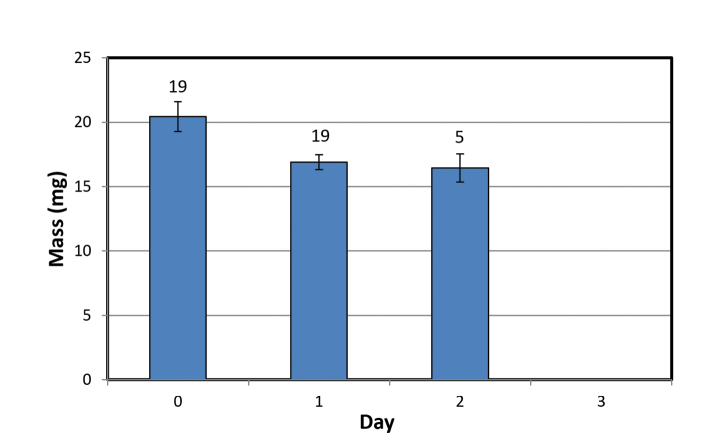
Mean masses of Ligidiumlapetum in 100% RH. The mean mass of the surviving animals on Day 2 is the mean % mass loss of those animals, subtracted from the mean of all animals at Day 0. No animal survived to Day 3 or initiated ecdysis.